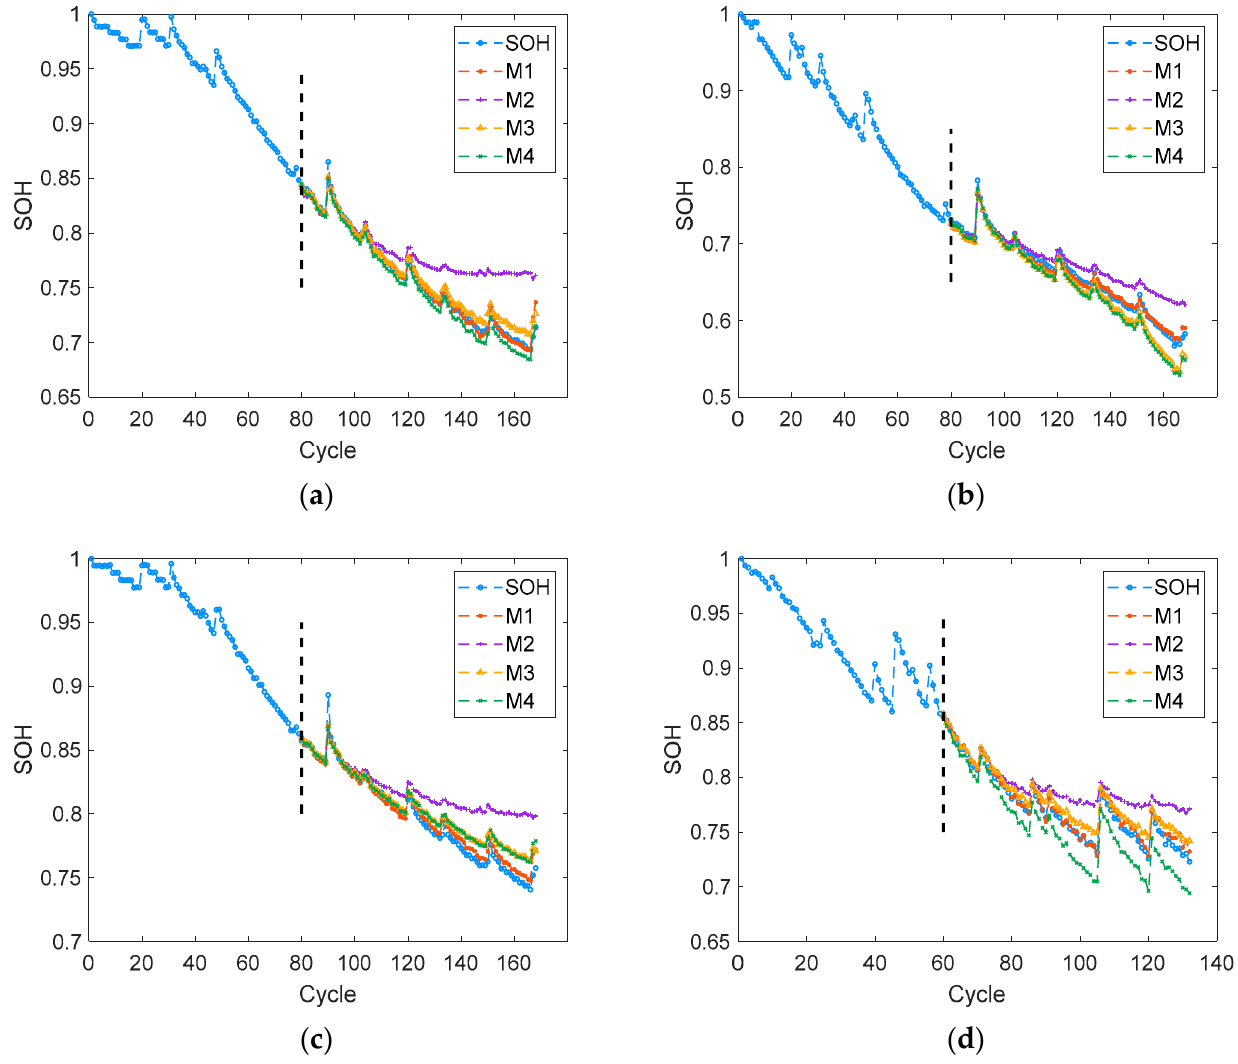
Figure 7. Prediction results on the comparisons for different models. ( a ) #5; ( b ) #6; ( c ) #7; ( d ) #18.